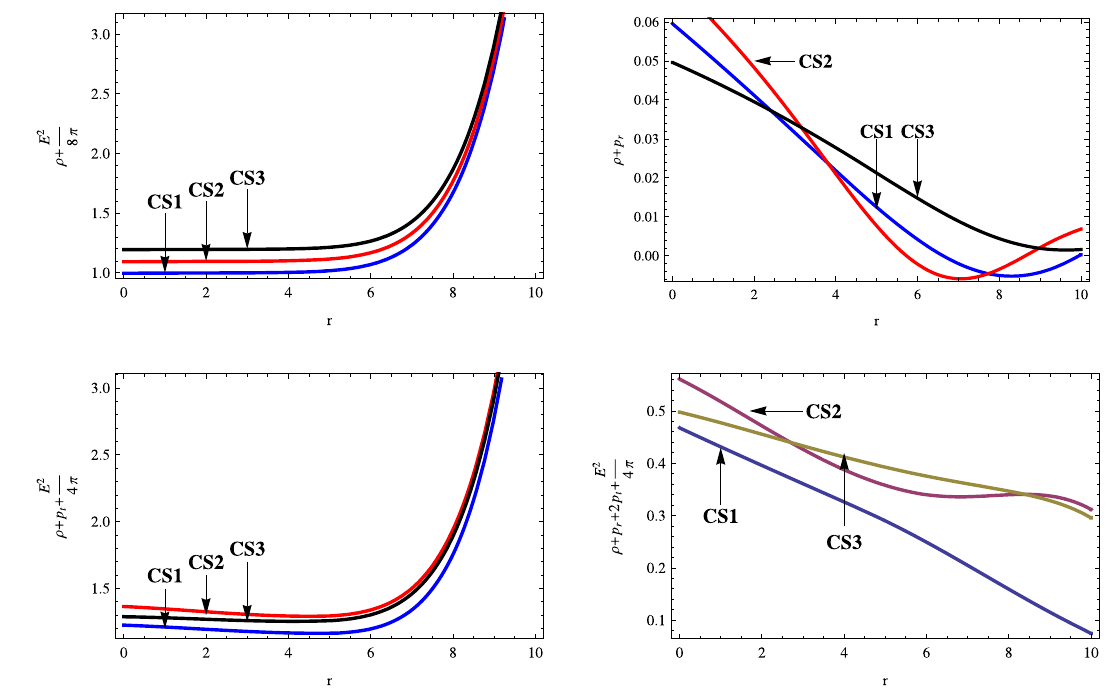
Fig. 11 Variations of energy conditions versus r (km) with the numerical values of A , B and C from Table 3